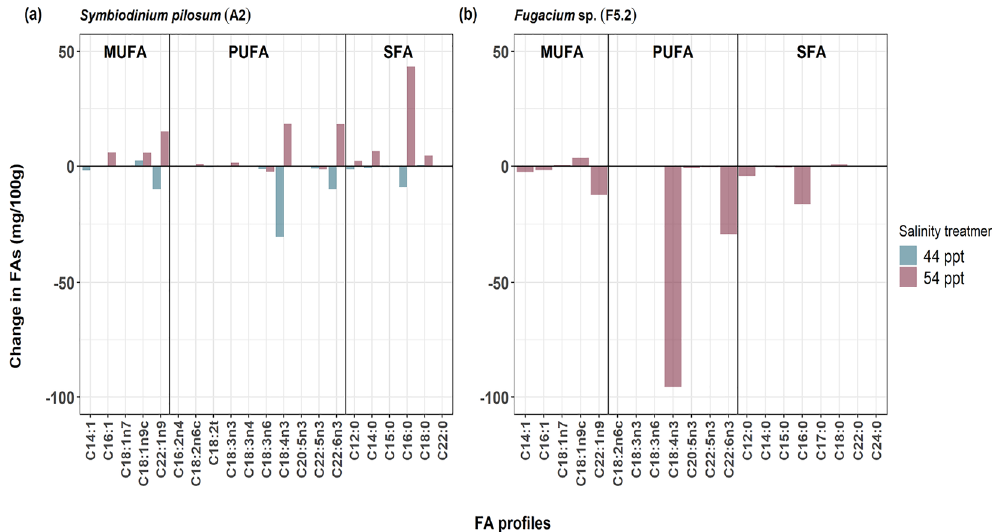
Figure 5. The changes in different fatty acid (FA) profiles of two Symbiodiniaceae culture isolates: ( a ) Symbiodinium pilosum [A2] after treatment with f/2 media at 44 ppt and 54 ppt salinities compared to f/2 media at 34 ppt (normal salinity; zero line); ( b ) Fugacium sp. [F5.2] after treatment with f/2 media at 54 ppt salinity in comparison to f/2 media at 34 ppt salinity (normal salinity). The values are in mg 100 g −1 change of fatty acid methyl